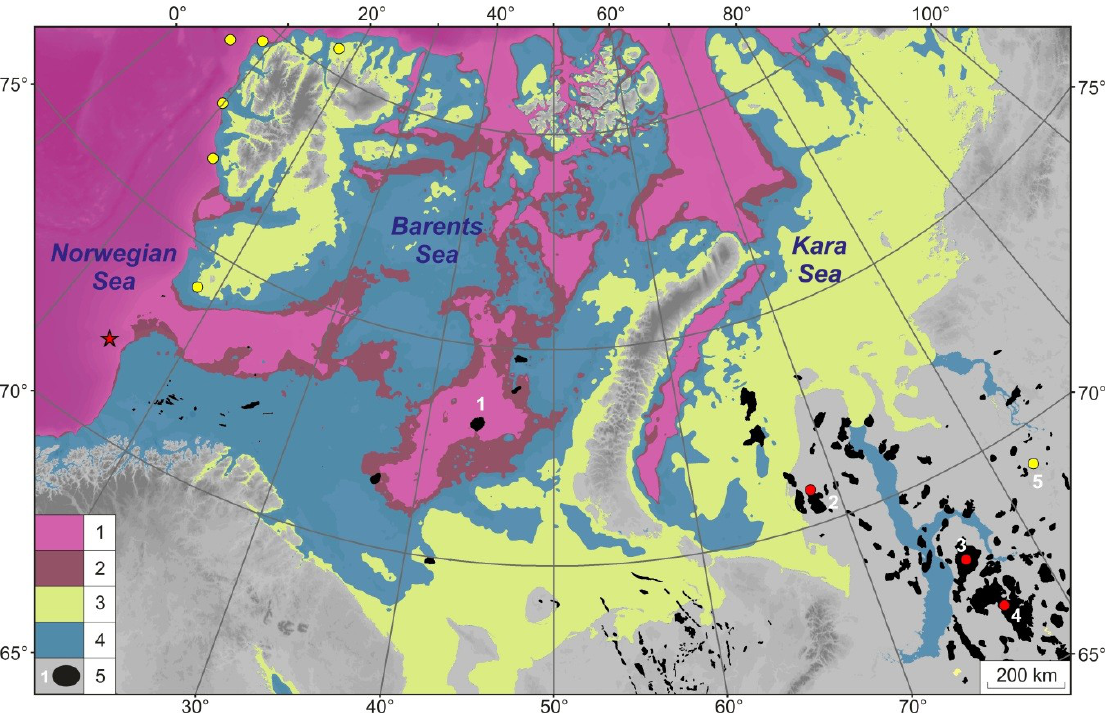
Figure 8. Scheme of probable MH distribution in the Norwegian, Barents and Kara seas. 1 and 2—zones with favorable thermobaric conditions for MH existence for Models 1 and 2 respectively, 3—favorable zone for subaquatic permafrost existence, 4—absence of appropriate conditions for MH existence in offshore areas, 5—conventional hydrocarbon fields, including those marked with white numbers—Shtokman (1), Bovanenkovo (2), Yamburg (3), Urengoy (4) and Messoyakha (5) [19].